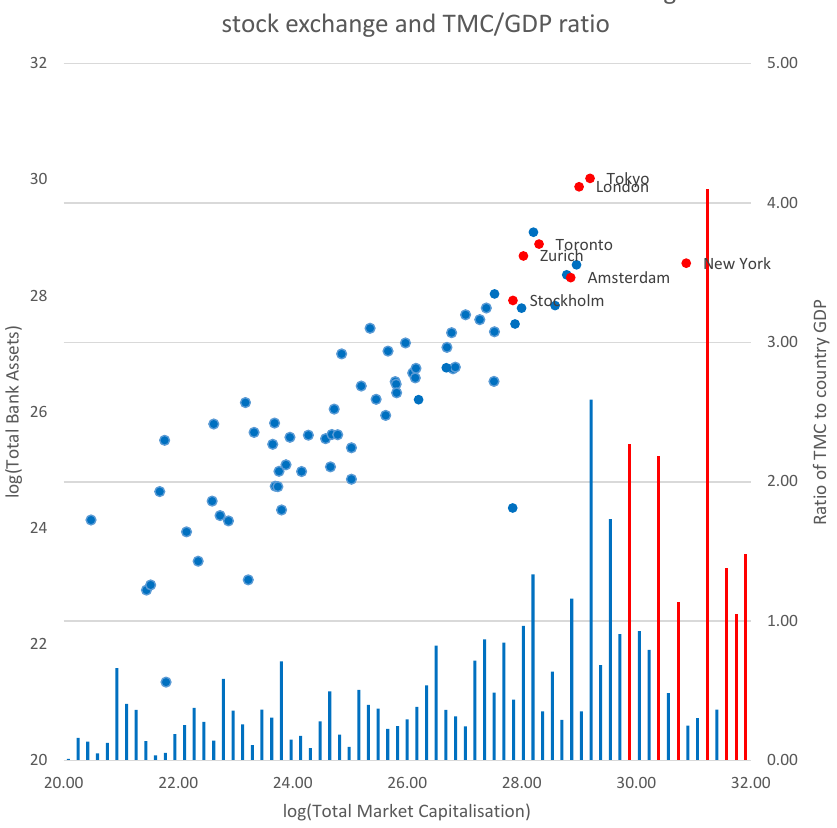
Figure 1. Average total TMC and TBA of cities with at least one registered stock exchange and the ratio of TMC to